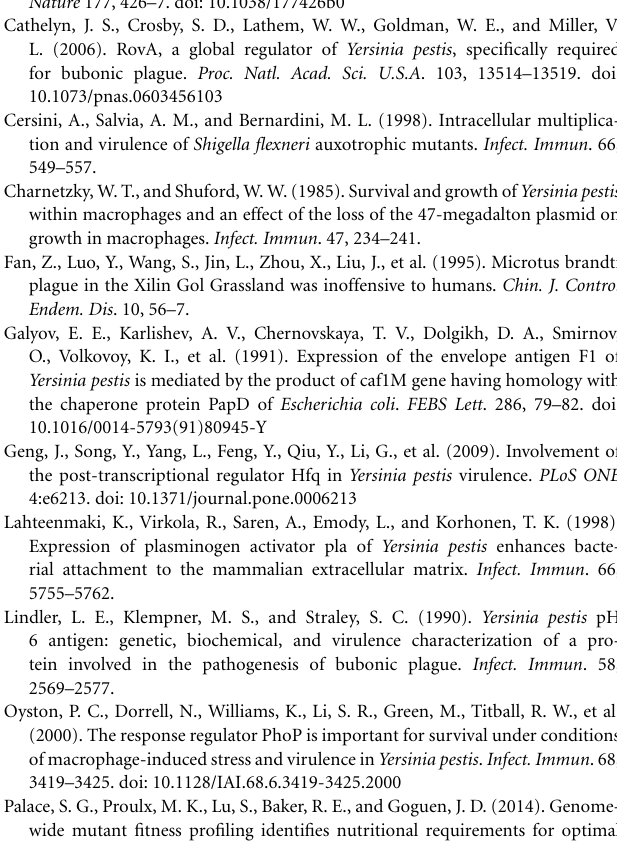
failed to affect LcrV expression at least in Y. pestis grown in vitro